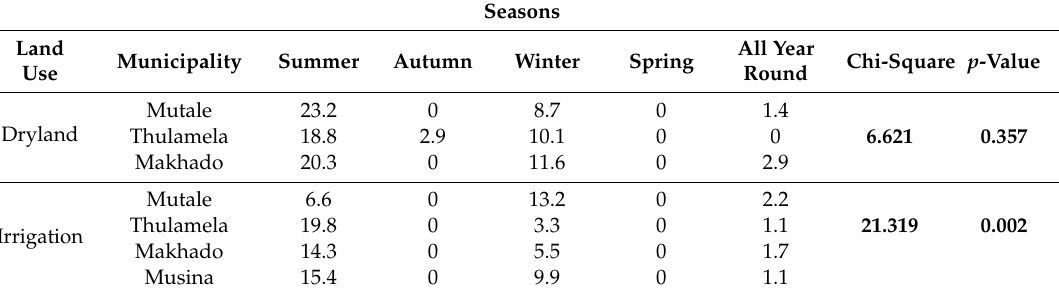
Table 8. Insect pest prevalence across seasons within